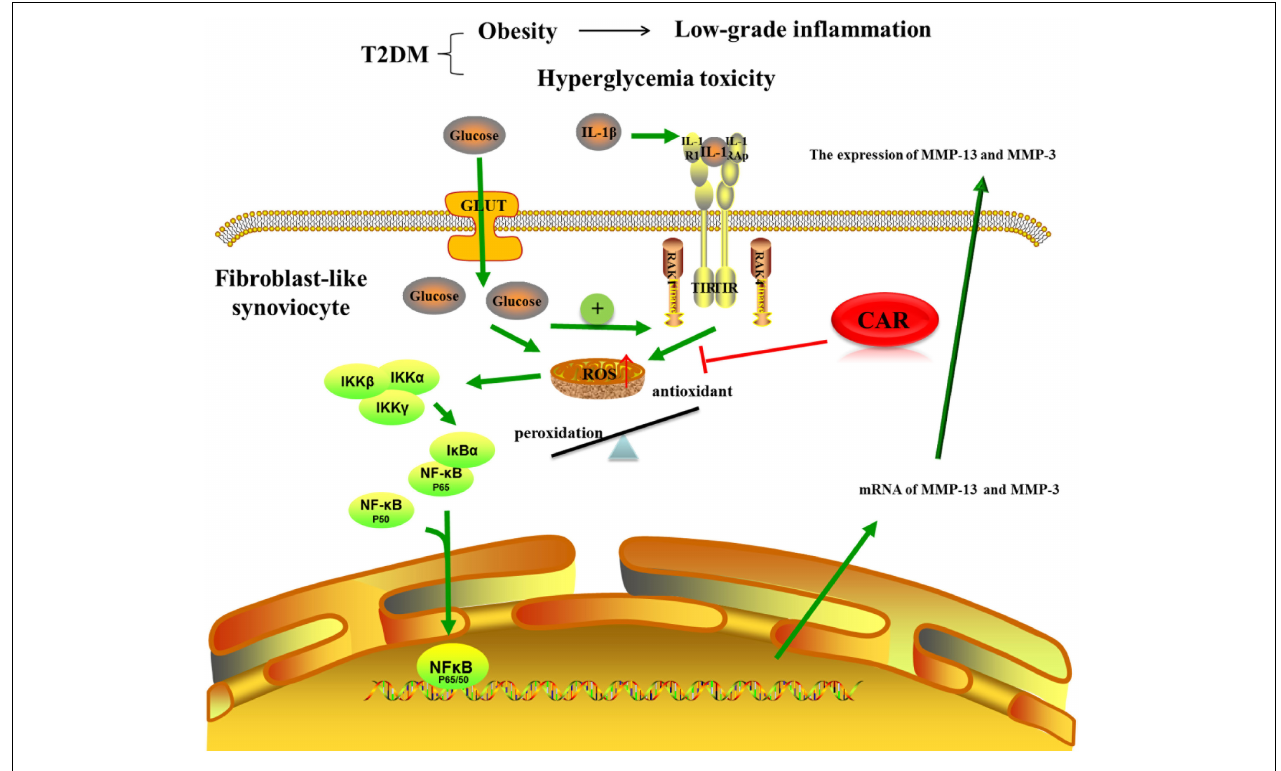
FIGURE 8 | The mechanism of CAR on IL-1 β -induced FLSs in a high glucose environment. CAR alleviated MMP-3 and MMP-13 expression by decreasing ROS content and suppressing nuclear translocation of NF- κ B p65 in IL-1 β -induced FLSs under a high glucose